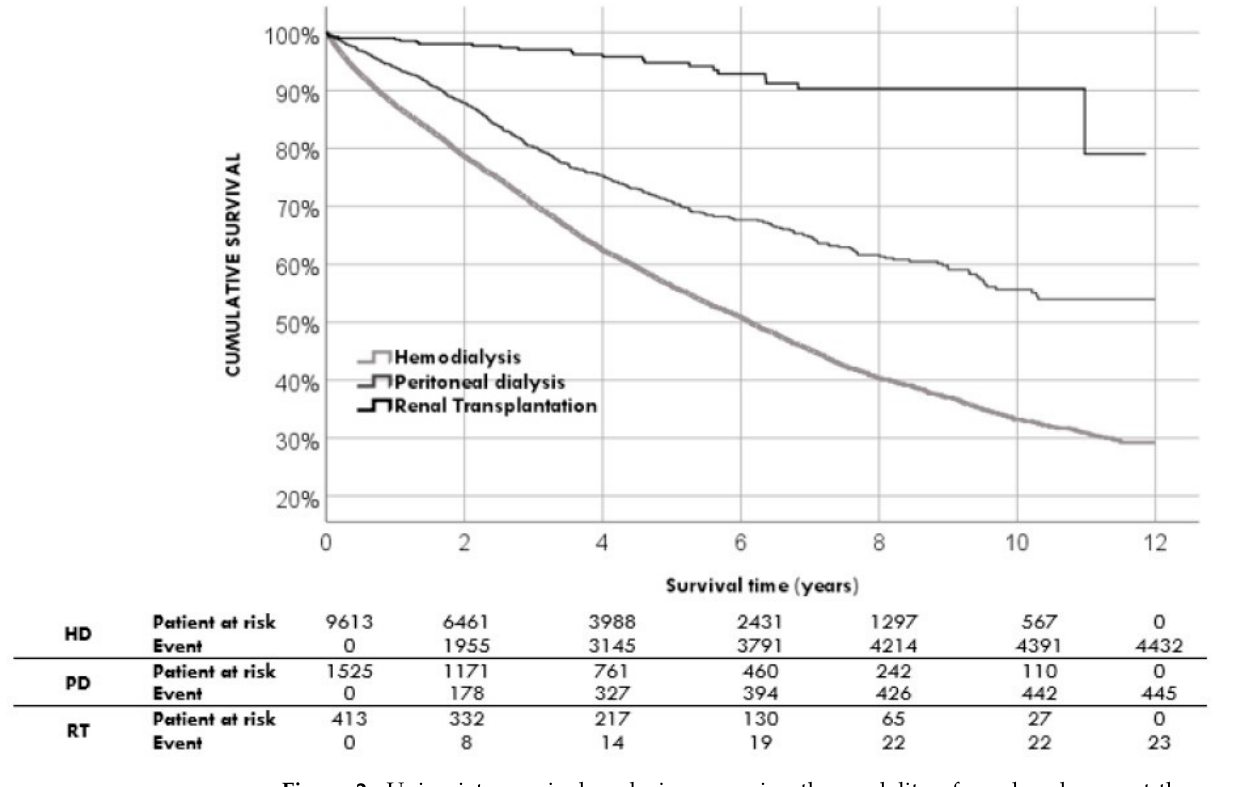
Figure 2. Univariate survival analysis comparing the modality of renal replacement therapy at the start. Table 3. Patient characteristic assessment related to survival. Table 4. Univariate Cox evaluation of prognostic factors in incident RRT